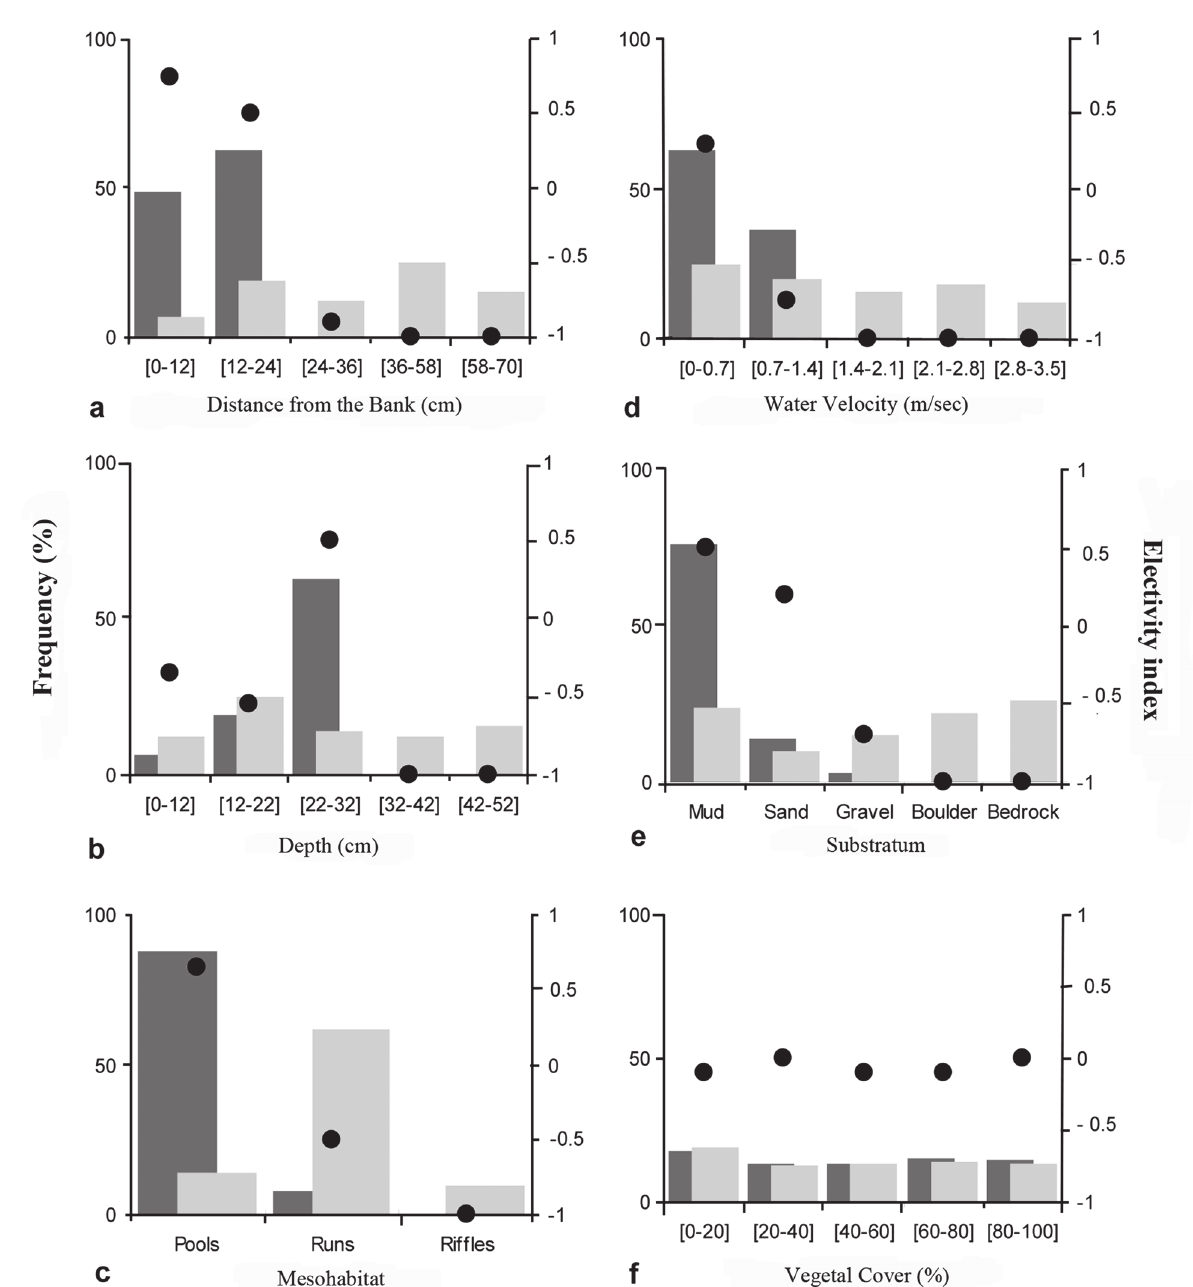
Fig. 4. Availablity (light grey bars), use (dark grey bars) and Ivlev Index (black circles) for the six studied microhabitat descriptors affecting adult individuals of Phalloceros harpagos populations from Mato Grosso stream: ( a ) distance from the nearest bank; ( b ) total depth; ( c ) mesohabitat; ( d ) focal water velocity; ( e ) substratum, and ( f ) vegetal cover